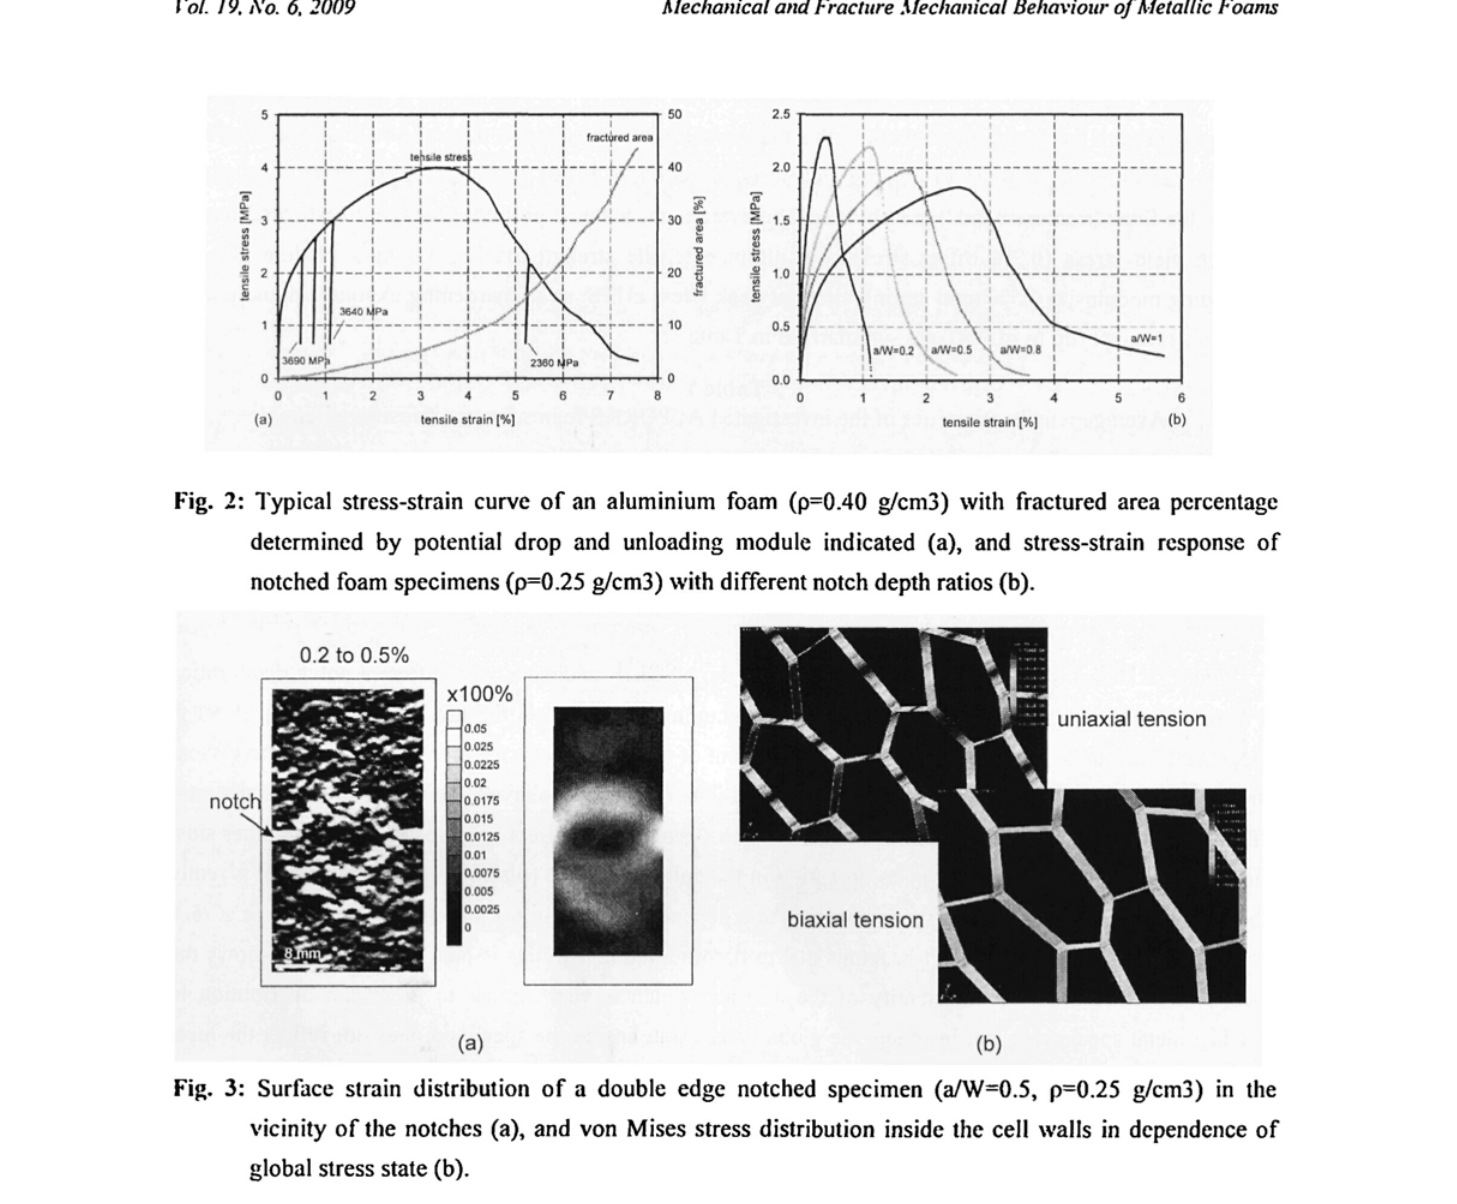
Fig. 3: Surface strain distribution of a double edge notched specimen (a/W=0.5, p=0.25 g/cm3) in the vicinity of the notches (a), and von Mises stress distribution inside the cell walls in dependence of global stress state